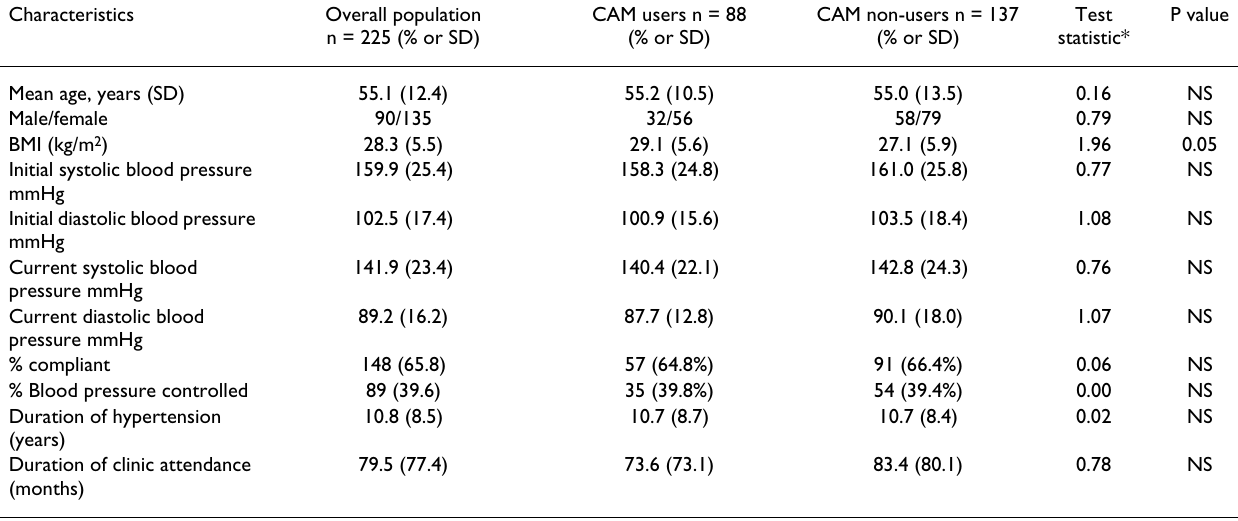
Table 1: Demographic and clinical characteristics of hypertensives using or not using complementary and alternative therapies